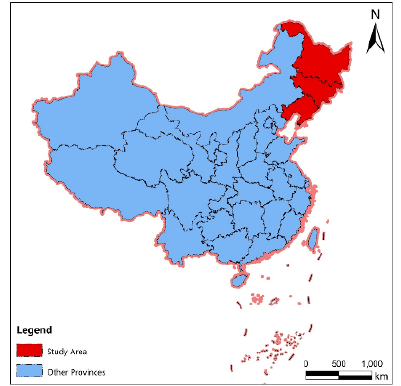
Figure 1. Location of study area.